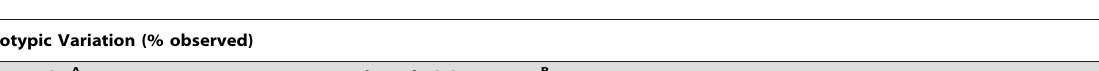
Phenotypic Variation (% observed) Cleft Severity A